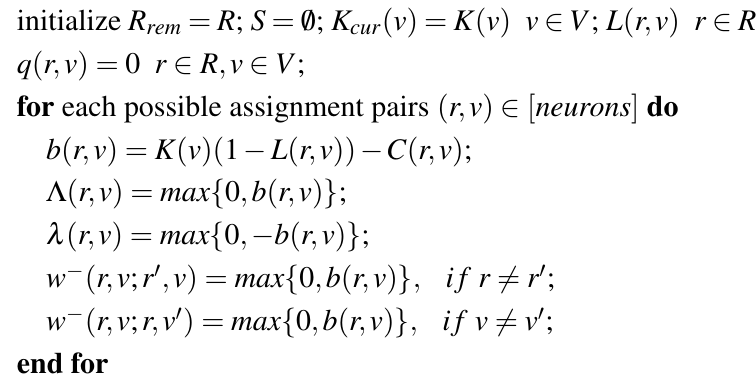
Algorithm 1 Task assignment for optimal emergency